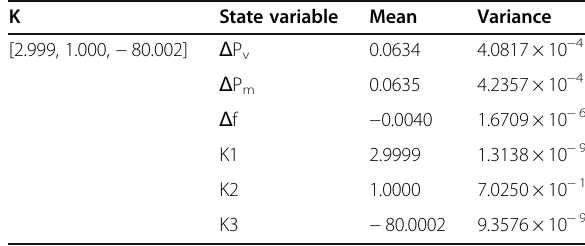
Table 1 Mean and variance of state variables estimated corresponding to a measurement noise variance of